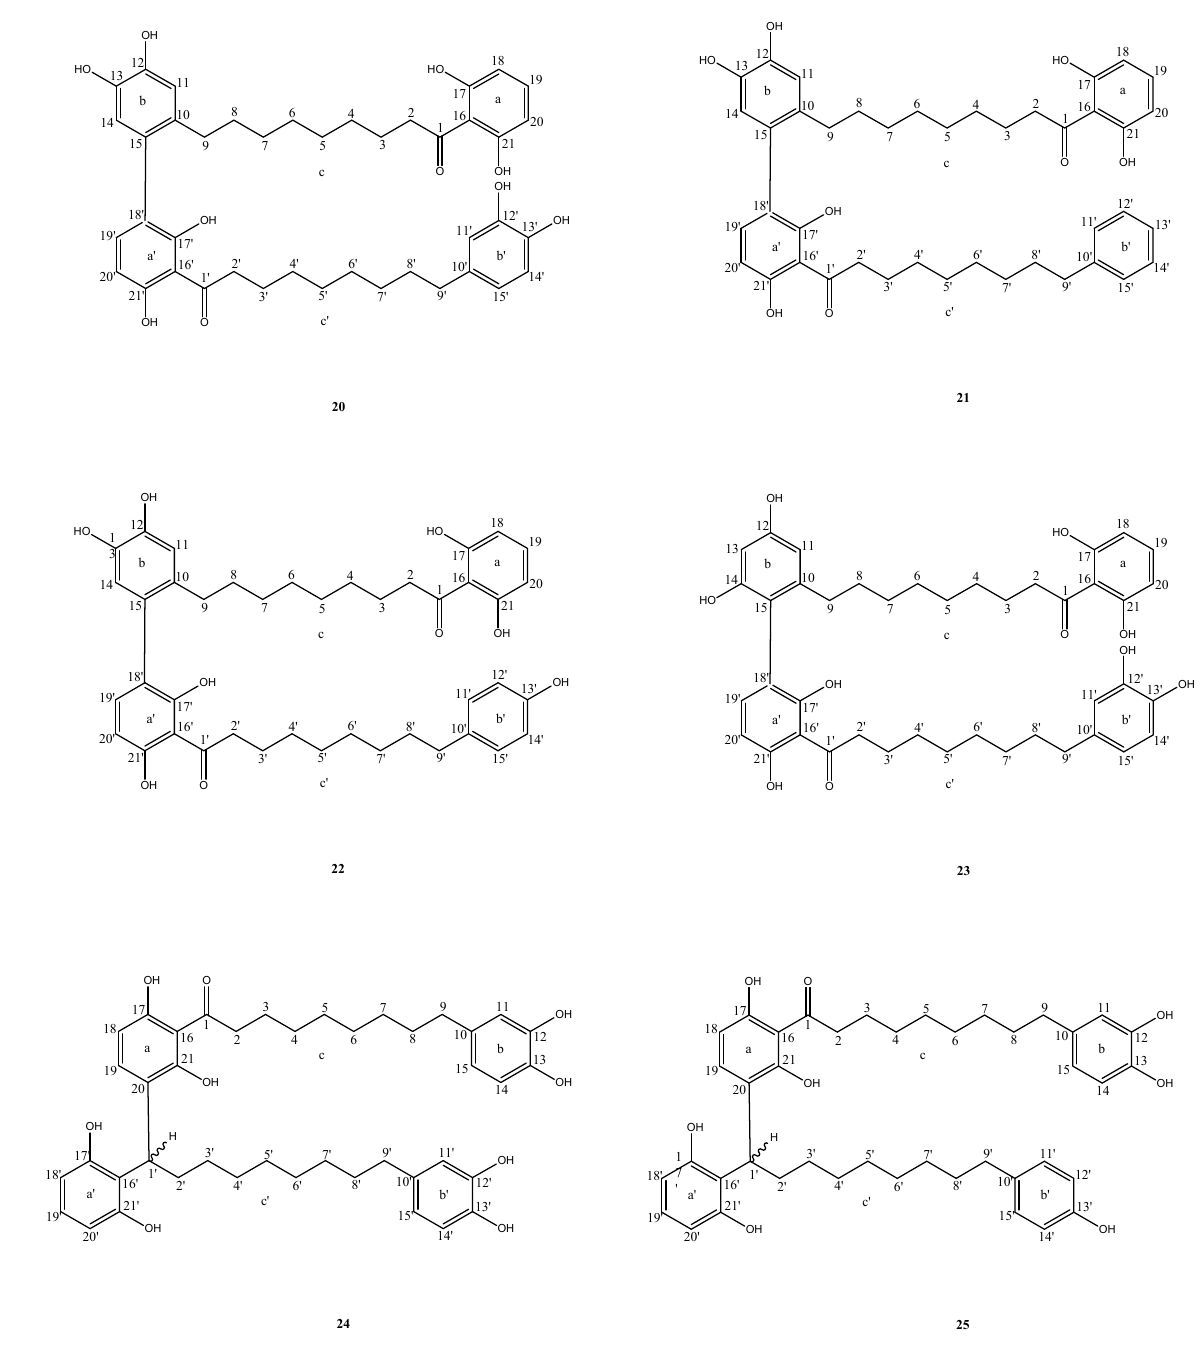
Figure 2. Dimeric Acylphenols from the genus Myristica.